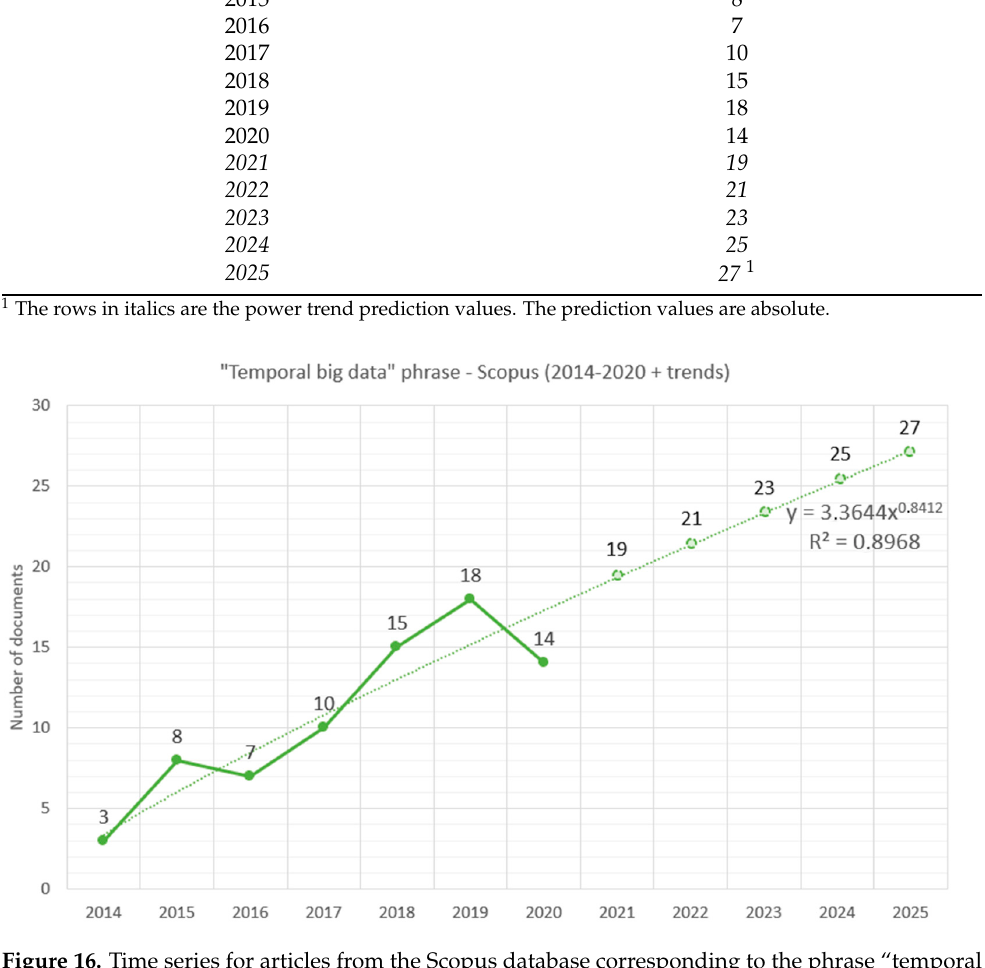
Figure 16. Time series for articles from the Scopus database corresponding to the phrase “temporal big data” (for the years 2014–2020) with the power trendline (with the highest value of R 2 ) and fore- casted values (absolute) for the years